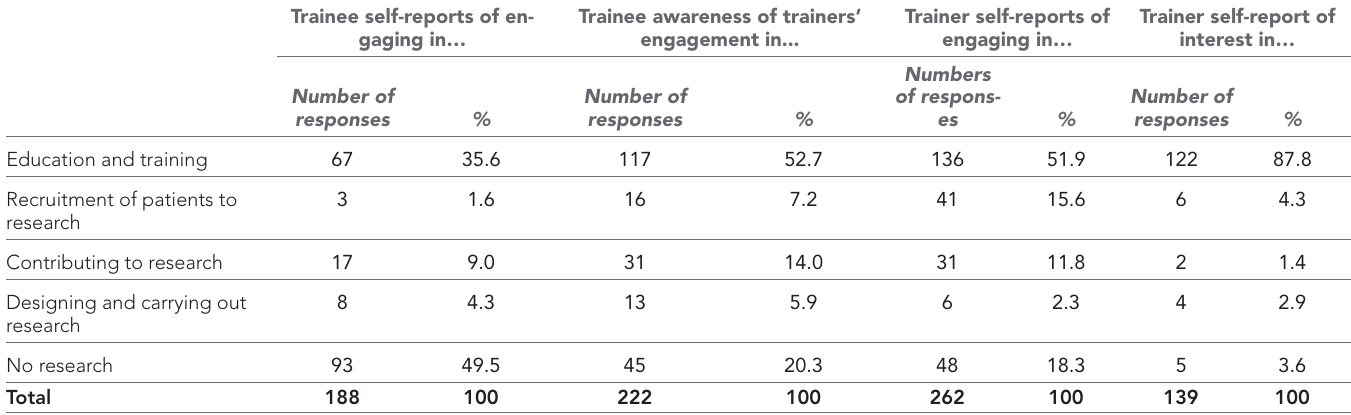
Table 4 Trainee and trainer research engagement